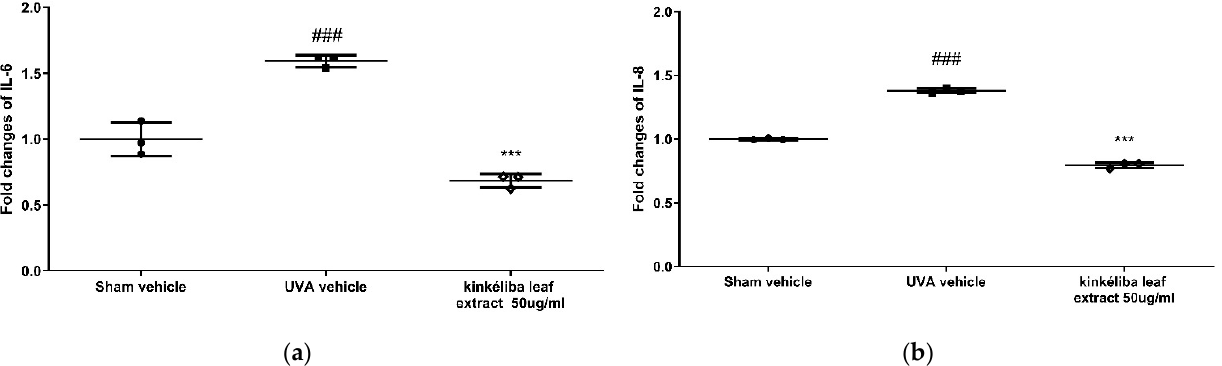
Figure 2. Treatment reduced UVA-induced inflammatory cytokines. Cells were treated with kinkéliba leaf extract and cultured for 24 h after UVA irradiation. The formation of inflammatory cytokines IL-6 ( a ) and IL-8 ( b ) were evaluated by means of ELISA. Each value is presented as the mean ± SD from triplicate independent experiments. Significantly different from sham vehicle, ### p < 0.001; UVA vehicle, *** p < 0.001.